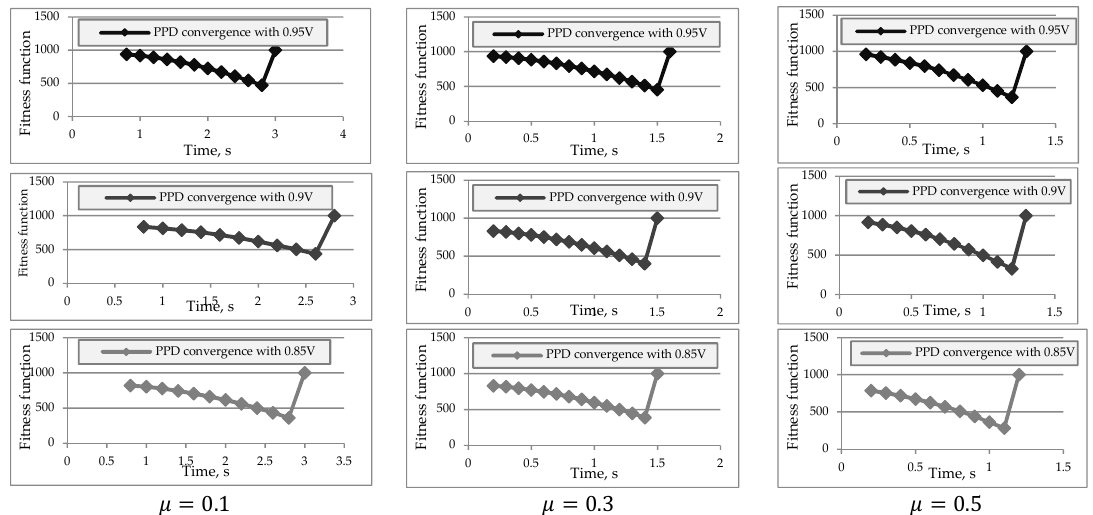
Figure 15. Target quality function convergence of the PPD controllers under the different speed levels and friction values ( µ = 0.1, 0.3, 0.5) depends on time prediction.